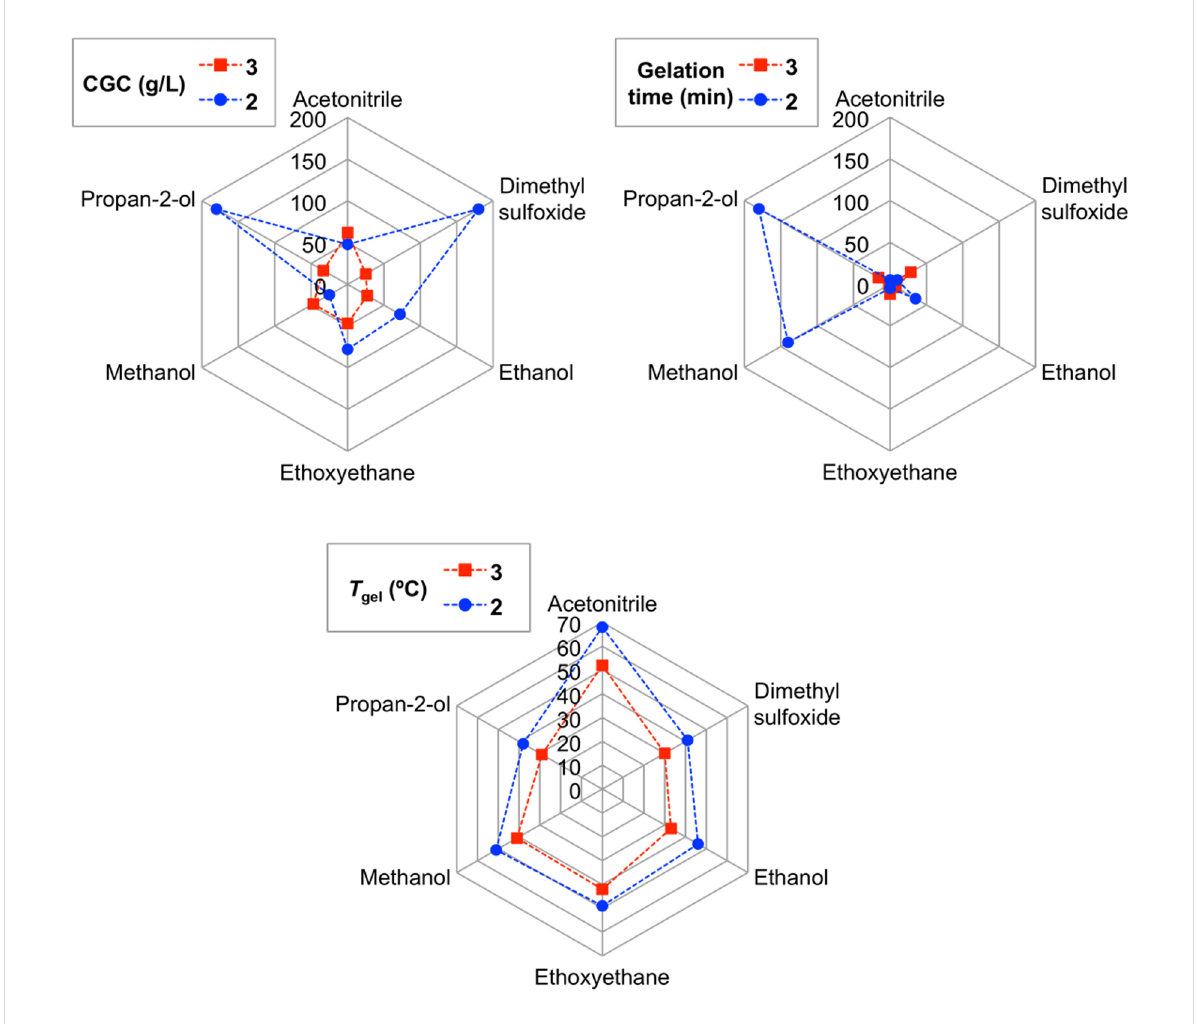
Figure 2: Comparison of CGC, gelation time and T gel values corresponding to six gels made using 3 and 2 [33] as gelators.